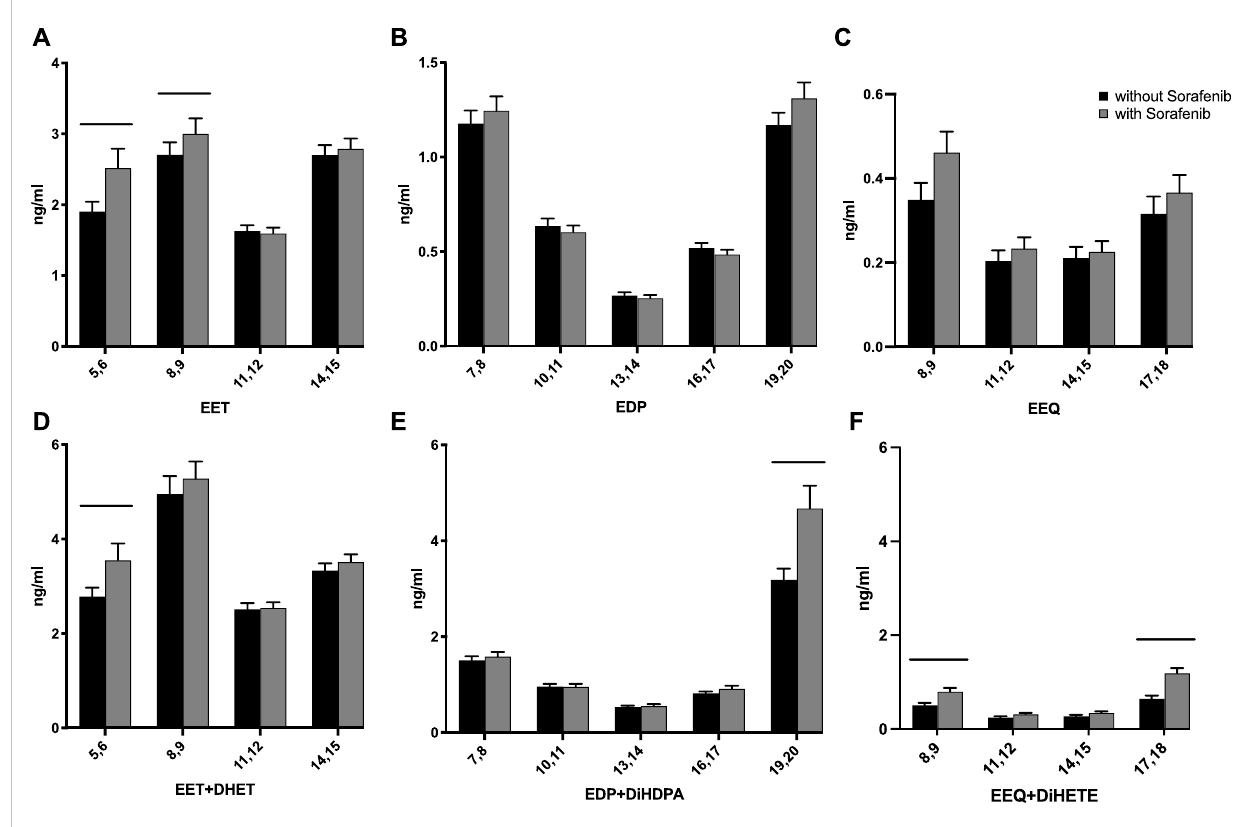
FIGURE 2 Effects on the concentrations of (A) AA-, (B) DHA-, and (C) EPA-derived epoxy-PUFA EETs, EDPs, and EEQs; and (D) AA-derived epoxy-PUFA plus dihydroxy-PUFA, (E) DHA-derived epoxy-PUFA plus dihydroxy-PUFA, and (F) EPA-derived epoxy-PUFA plus dihydroxy-PUFA in the plasma of n = 43 patients with hepatocellular carcinoma (HCC) without and undergoing sorafenib treatment (ng/mL ± standard error of the mean). Statistical differences were determined using the Wilcoxon signed-rank test (** p < 0.01; *** p < 0.001; **** p <